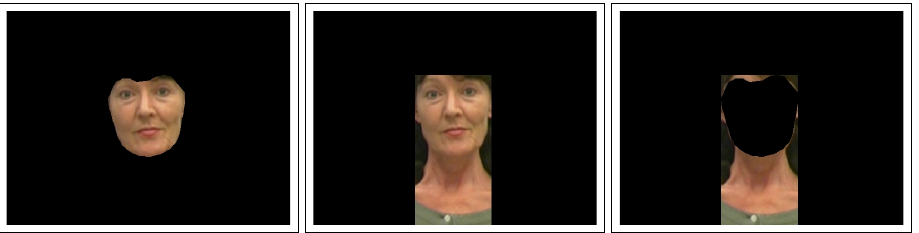
Figure 6. Illustration of the proposed representations for anomaly detection based on image fore- ground Img Face ( right ). Image originates from VidTIMIT [42] dataset with application of keypoint generation by dlib [36] and